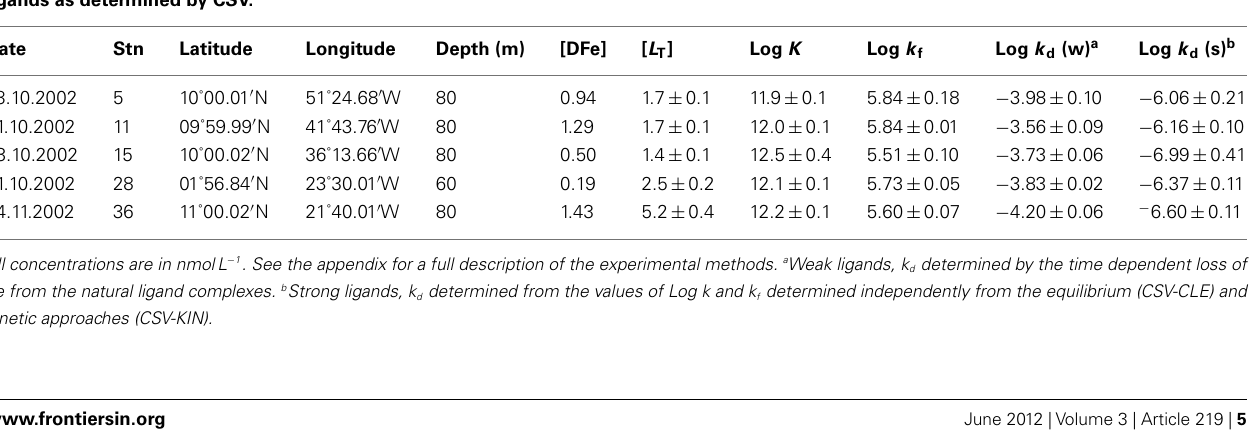
Table 1 | CSV-KIN: results from the Meteor Expedition (M55) in theTropical NorthAtlantic: Formation and Dissociation rates of natural iron ligands as determined by